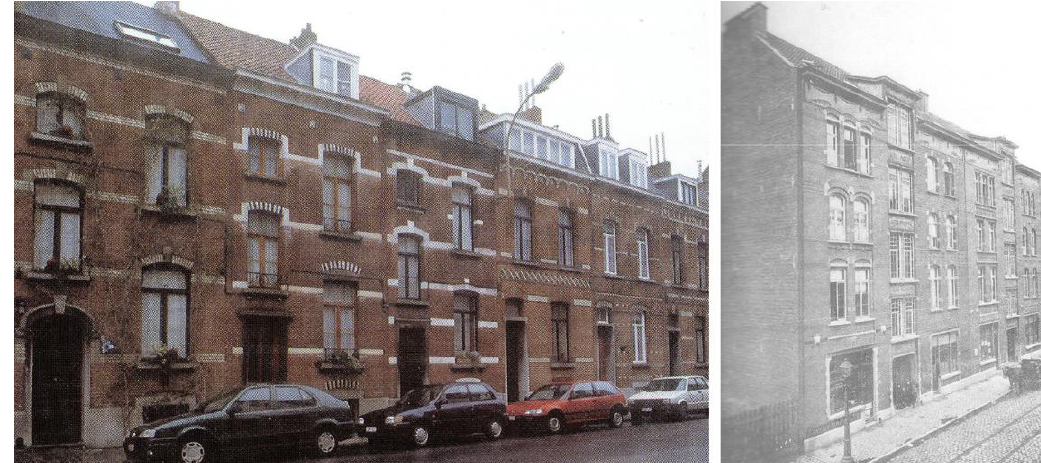
Figure 1 . Owner-occupied and tenant housing Victor Hugo (date unknown). Source data: Huberty,